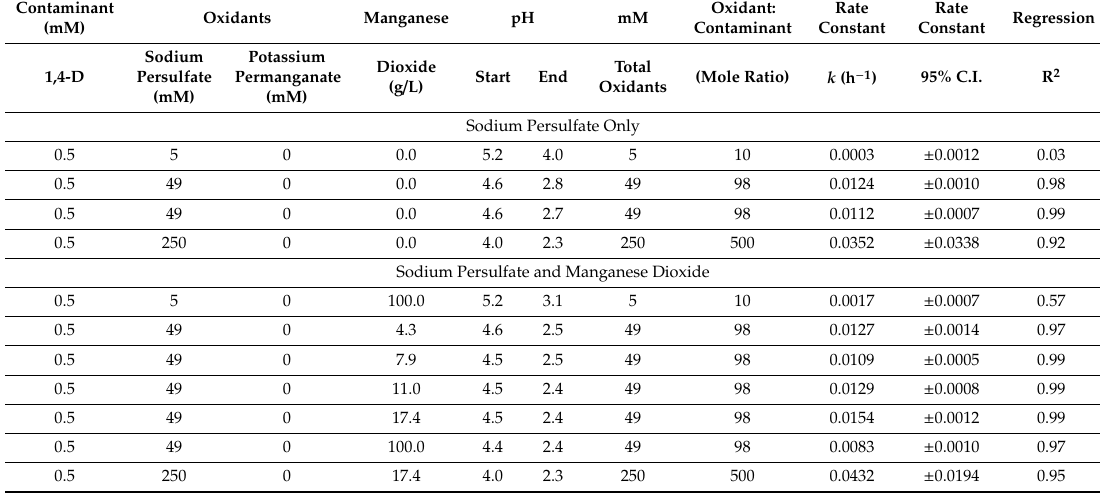
Figure 5. Relative concentration as a function of time illustrating removal kinetics of 1,4-D using PS with various KMnO 4 amendment amounts. Relative concentrations were normalized by the initial 0.5 mM of 1,4-D. Error bars represents the standard deviation triplicate replicates. Table 1. Summary of experimental conditions and resulting 1,4-D removal pseudo 1st order rate constant mean and 95% C.I. values.